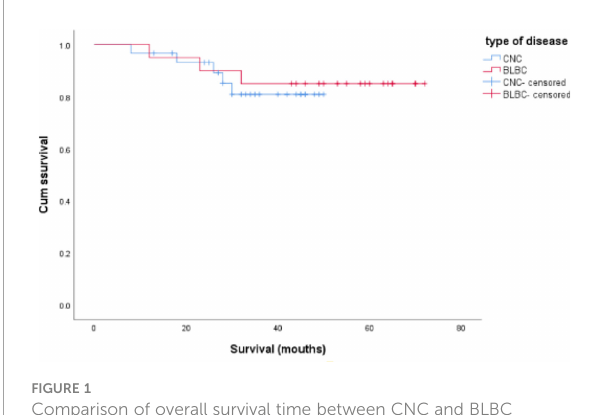
FIGURE 1 Comparison of overall survival time between CNC and BLBC patients, and the data analysis was not statistically signi fi cant (log- rank = 0.125, p >